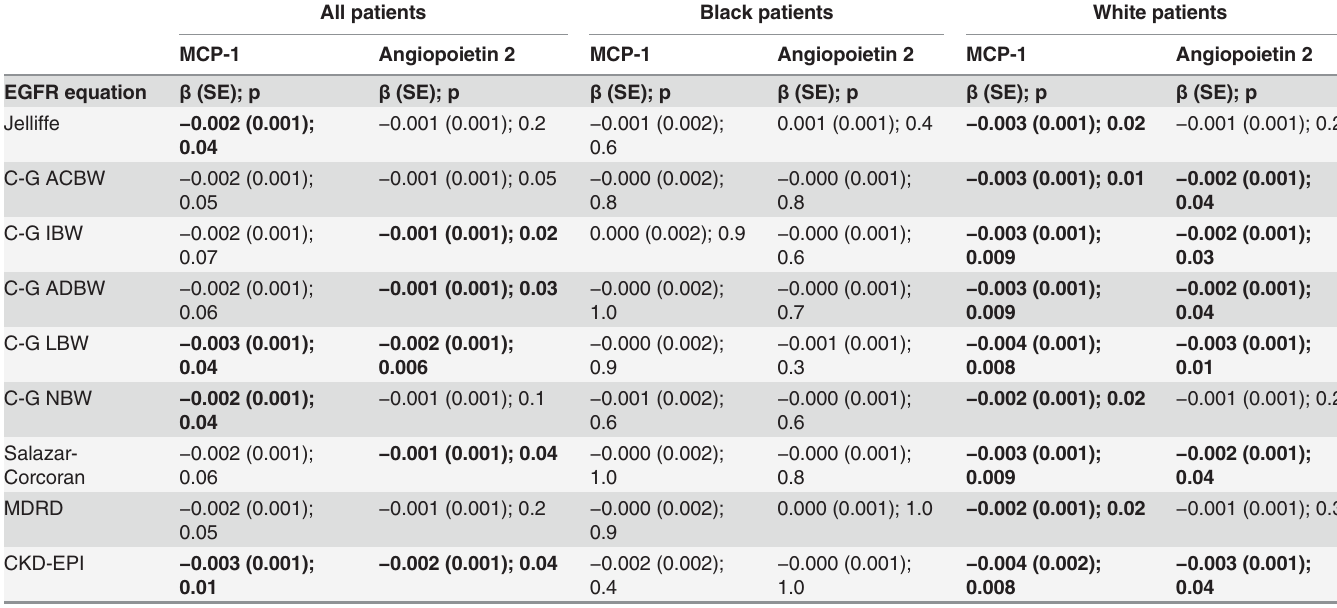
Table 3. EGFR formulas and endothelial activation in all, black, white, normal weight and obese patients with RA. All